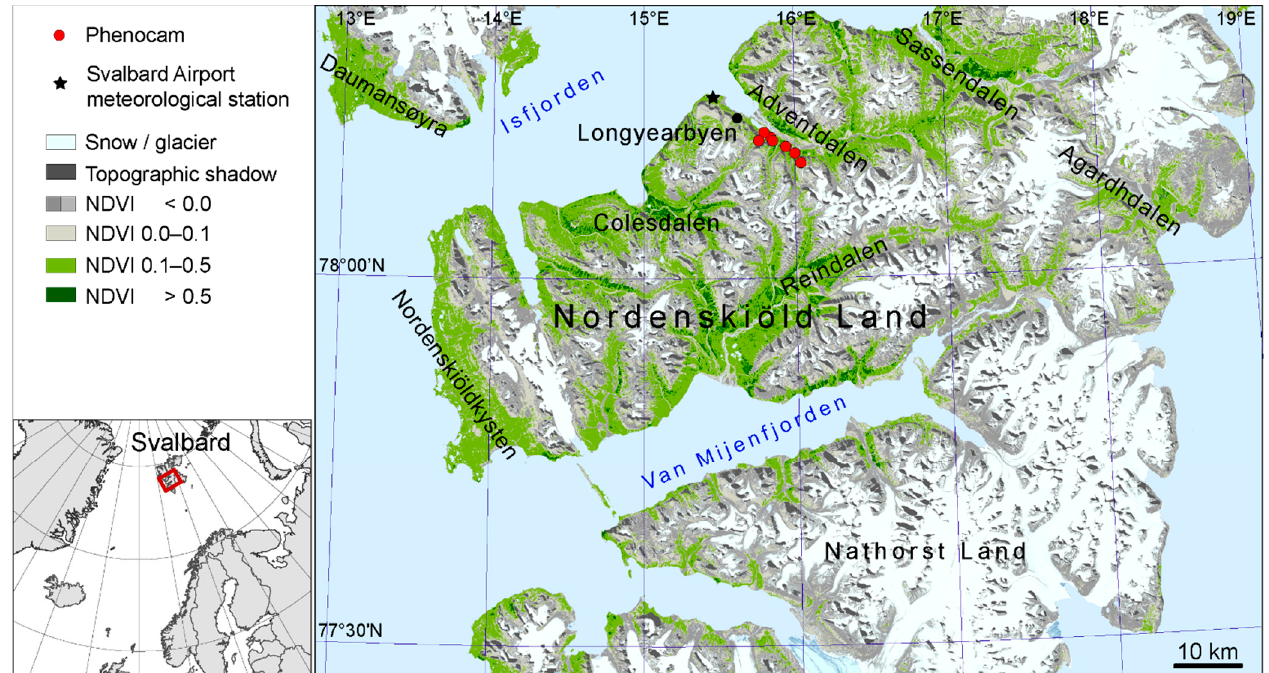
Figure 1. The study area of central Spitsbergen, Svalbard, showing mean NDVI values for the 25 July to 1 August period (4-year mean (2016–2019)). Snow/glacier mean values are shown for the same period, extracted from NDSI values (see text). The topographic shadow is approximate when the S2 passes in late July. The map also shows the location of the phenocams used in this study.